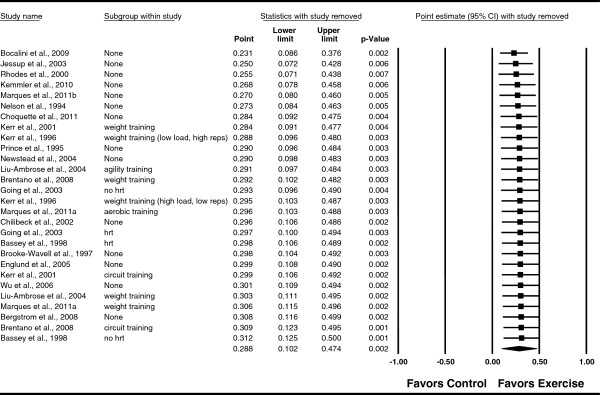
Influence analysis for changes in FN BMD. Influence analysis for point estimate standardized effect size changes (g) in FN BMD with each corresponding study deleted from the model once. The black squares represent the standardized mean difference (g) while the left and right extremes of the squares represent the corresponding 95% confidence intervals. The middle of the black diamond represents the overall standardized mean difference (g) while the left and right extremes of the diamond represent the corresponding 95% confidence intervals. Results are ordered from smallest to largest values of g. For subgroup, HRT means hormone replacement therapy.